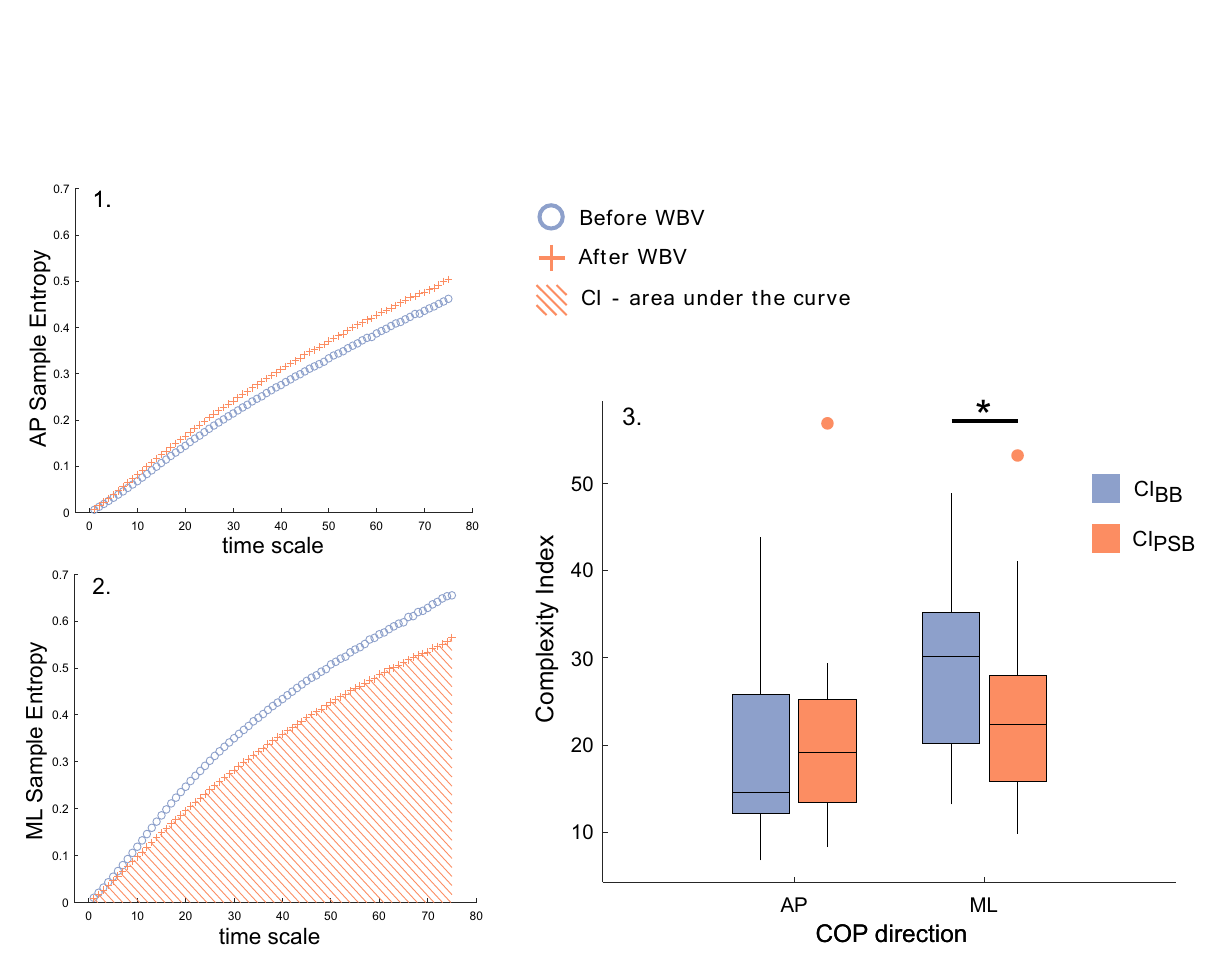
Figure 6. Multiscale sample entropy and complexity index. Plots of sample entropy averaged across subjects in the anterior–posterior ( 1 ) and in the medial–lateral direction ( 2 ) before and after the WBVS (round and cross marker, respectively). In ( 2 ), the area under the curve is displayed to represent the calculation of the CI for the ML direction, post stimulation. In ( 3 ) boxplots of the complexity index are displayed for the ML and AP direction (CI ML and CI AP ) and significant differences are depicted by the asterisk ( p <